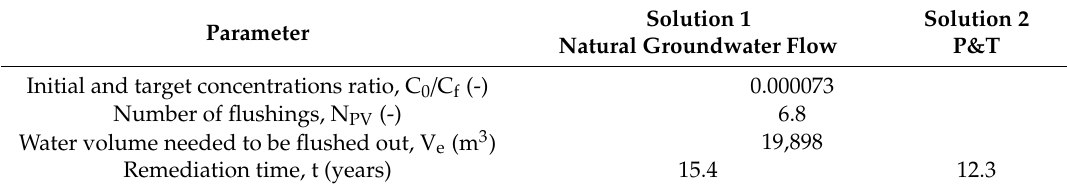
Table 8. ADR model results for the synthetic